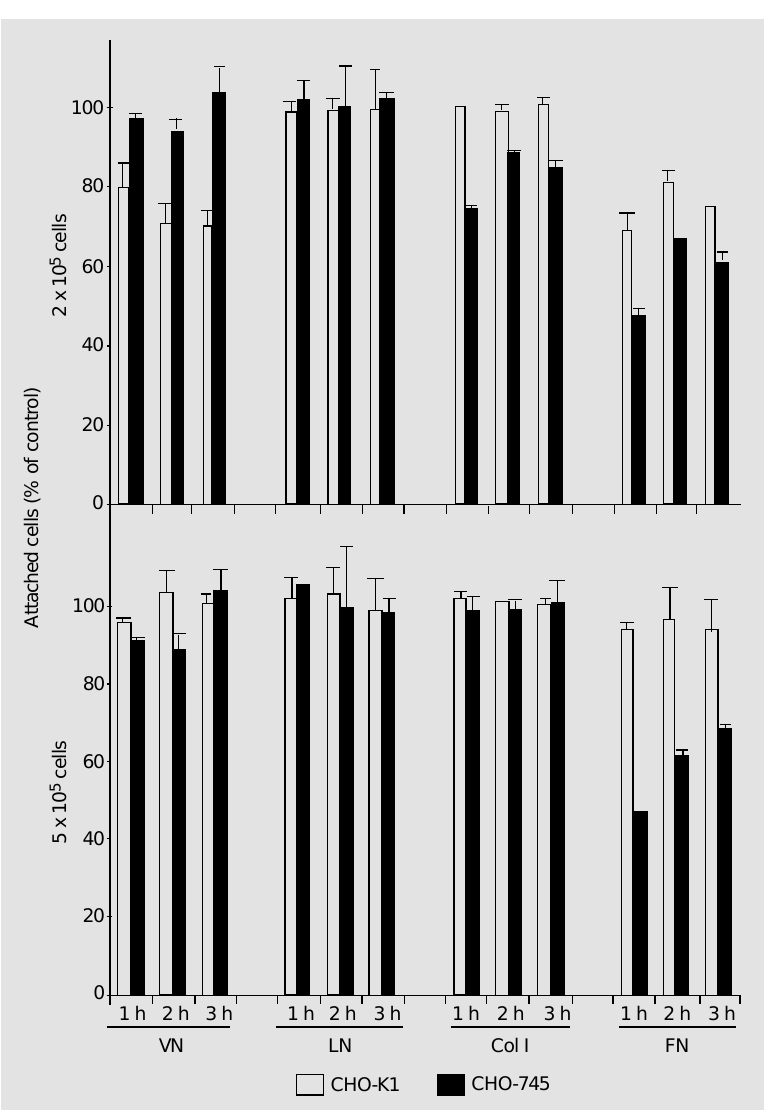
Figure 2. Effect of fucan on CHO cell adhesion to different matrix proteins. CHO cells, 2 x 10 5 or 5 x 10 5 , in 100 µl or 250 µl of cell suspension, respectively, were seeded on plastic plates coated with extracellular matrix proteins. The cells and fucan (100 µg/ml) were added simultaneously to 500 µl of F-12 medium containing 100 µg/ml fucan. CHO cells were stained with crystal violet. CHO cells that adhered to the surface at the indicated times were used as a measure of cell adhesion. The data are reported relative to the values in the absence of fucan, as means ± SD of four determinations. LN - laminin; FN - fibronectin; VN - vitronectin; Col I - type I